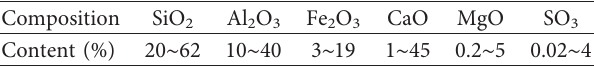
Table 4: FA chemical composition.